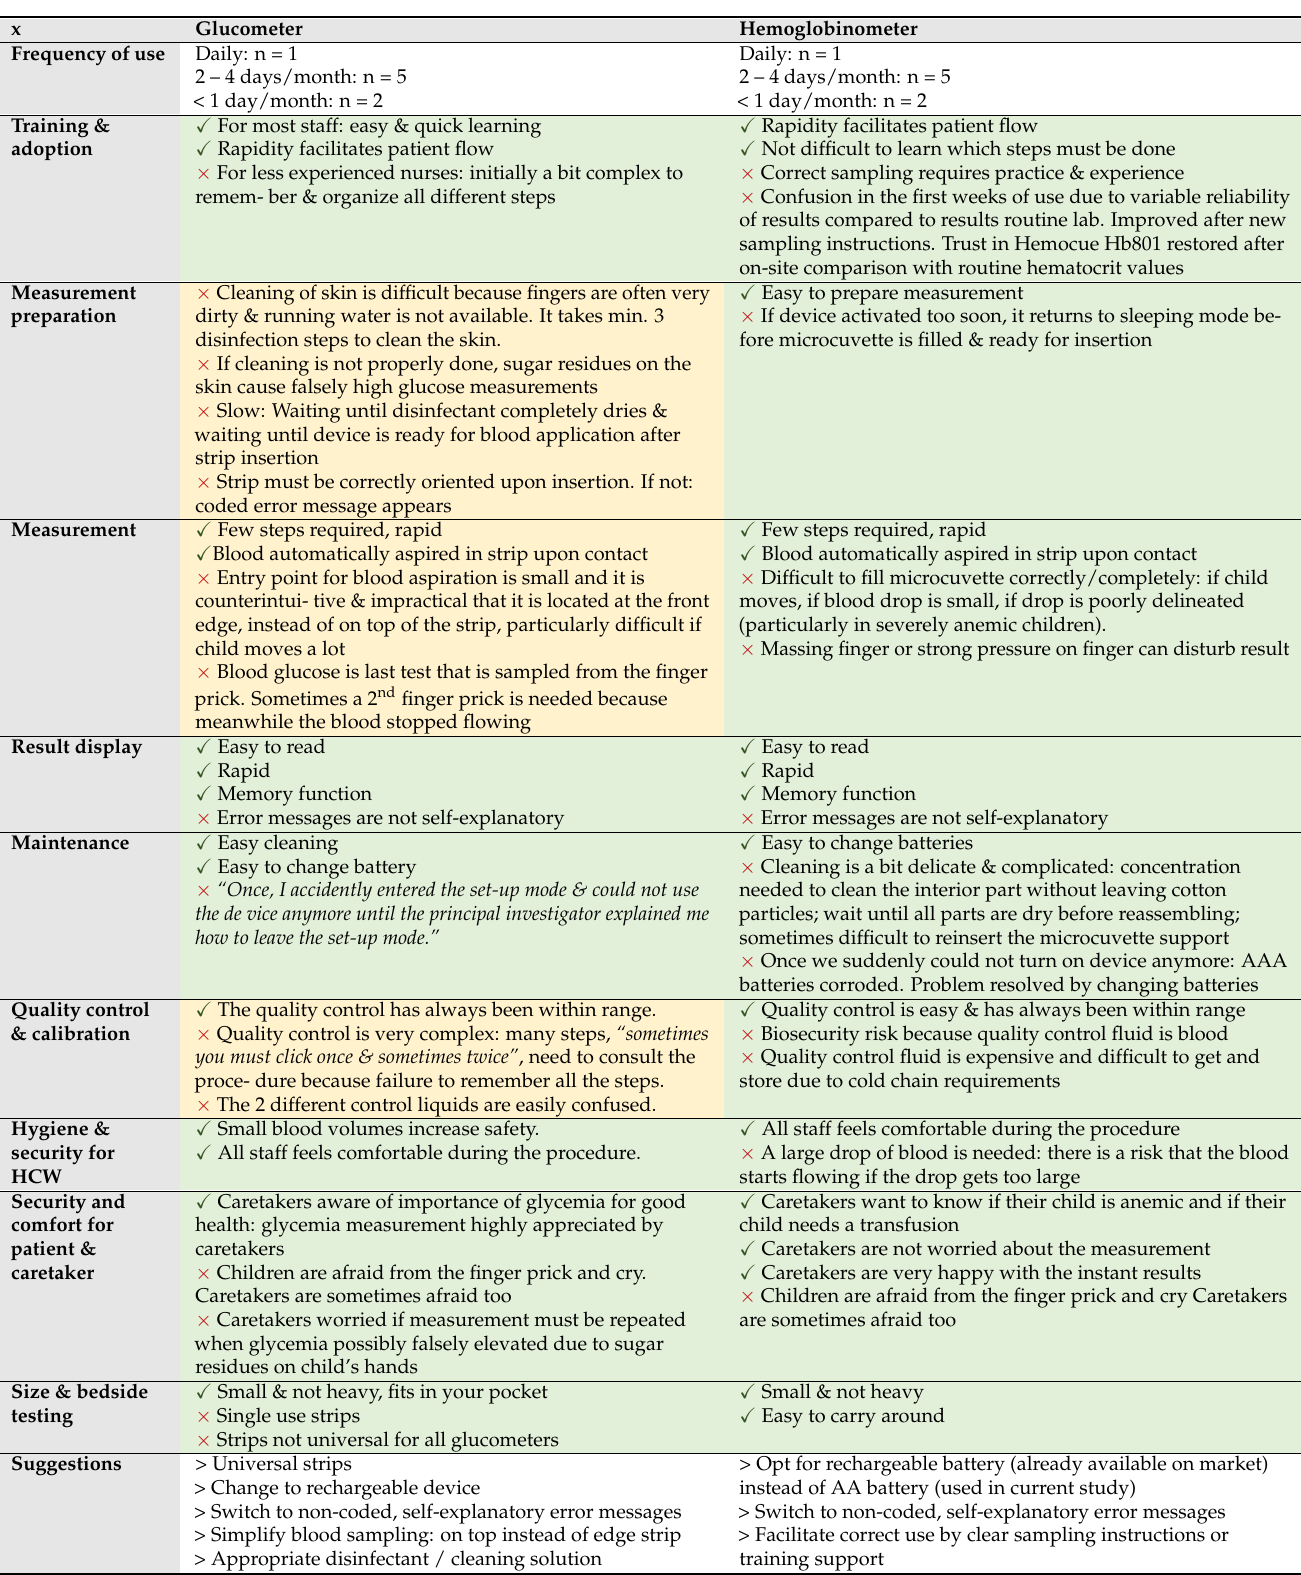
Table 3. Usability evaluation based on a semi-structured interview of end-users along the lifecycle of handheld diagnostic devices to measure blood glucose and hemoglobin. Legend: HCW: health- care workers, IFU: instructions for use, caretaker: parent or other person taking care of the child upon admission.